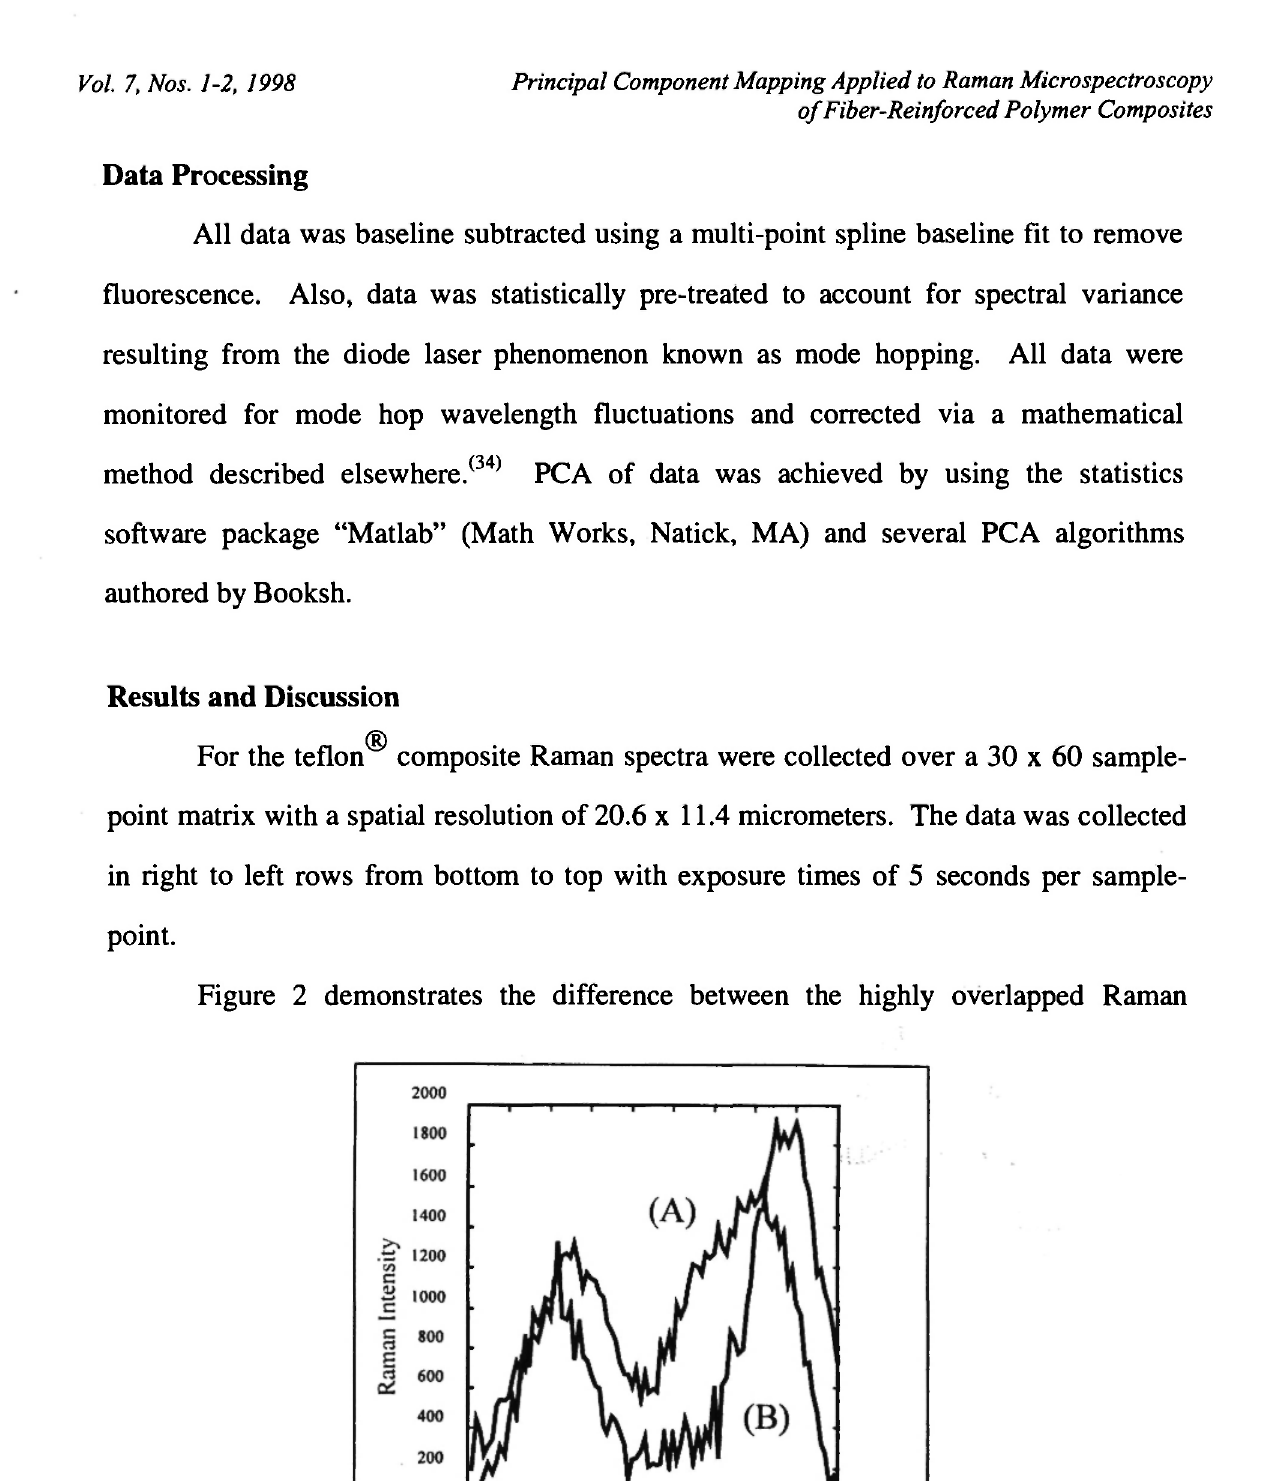
Figure 2: The highly overlapped Raman spectra of (A) teflon and (B) tripolyoxypropylenetriamine-encapped diglycidylether of bisphenol-A (DGEBA) epoxide.